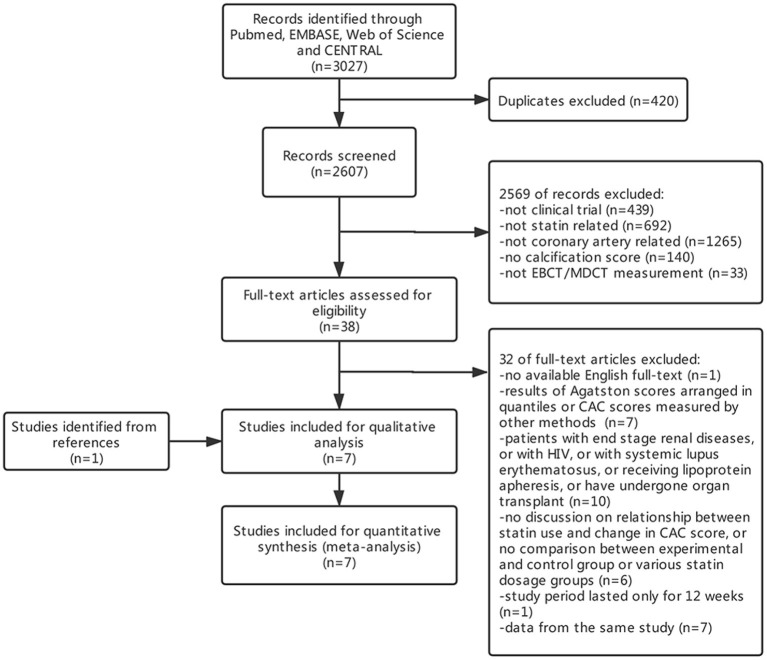
PRISMA flow chart of included studies.